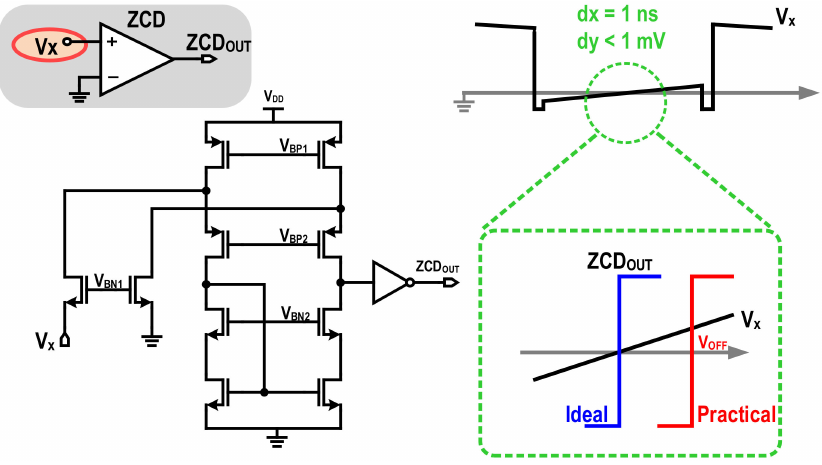
Figure 7. Common-gate comparator for conventional zero current